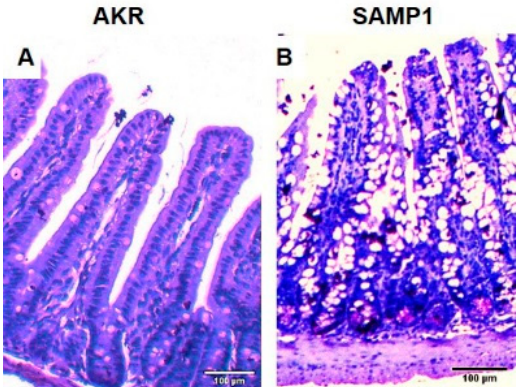
Figure 1. Representative example of cross section of the ileum of AKR and SAMP1 mouse stained with H&E. ( A ) AKR mouse intestine. ( B ) SAMP1 mouse intestine demonstrating crypt hypertrophy, villus blunting, and increased intra-epithelial lymphocytes characteristic of inflammatory bowel disease (IBD). Scale bar 100 μ m.